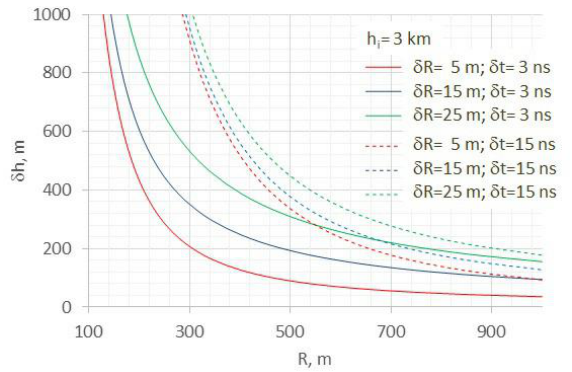
Figure 4. Axis distance distribution of the shower fraction de- Figure 5. The height of Cherenkov light emission maximum as Figure 2. Energy dependence of Full width at half-maximum of a function of time di ff erence the Cherenkov signal